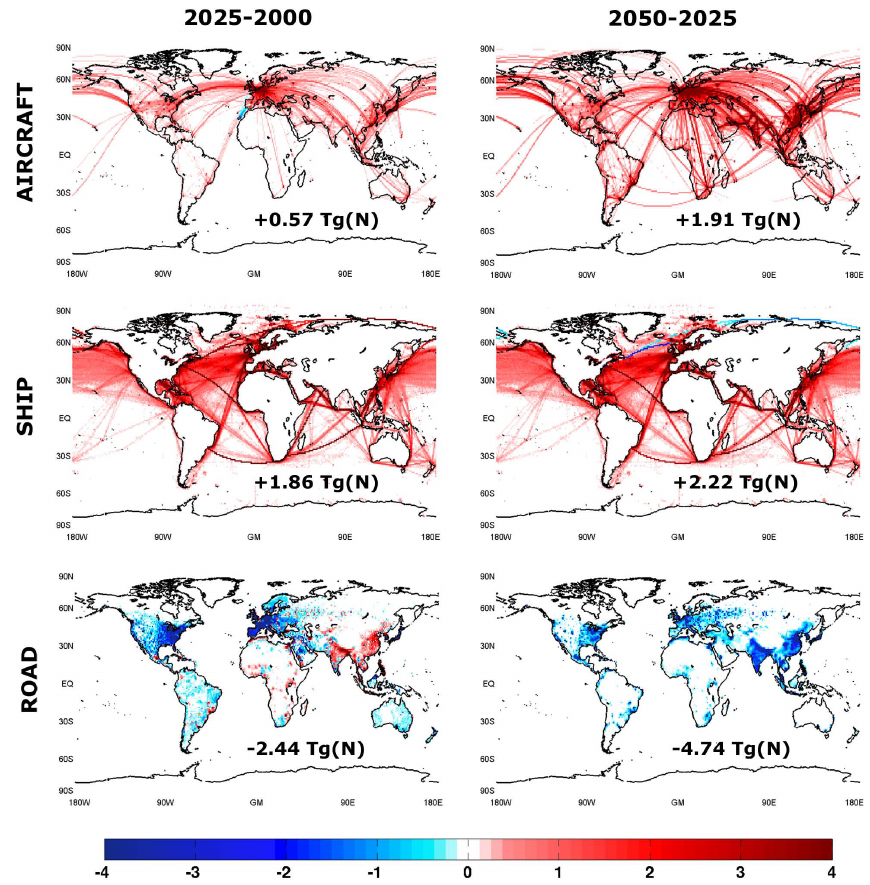
Fig. 1. Spatial distribution of the absolute difference in NO x emission flux for the SRES A1B scenario (units: 10 13 molecules NO 2 m − 2 s − 1 for AIRCRAFT and SHIP; 10 14 molecules NO 2 m − 2 s − 1 for